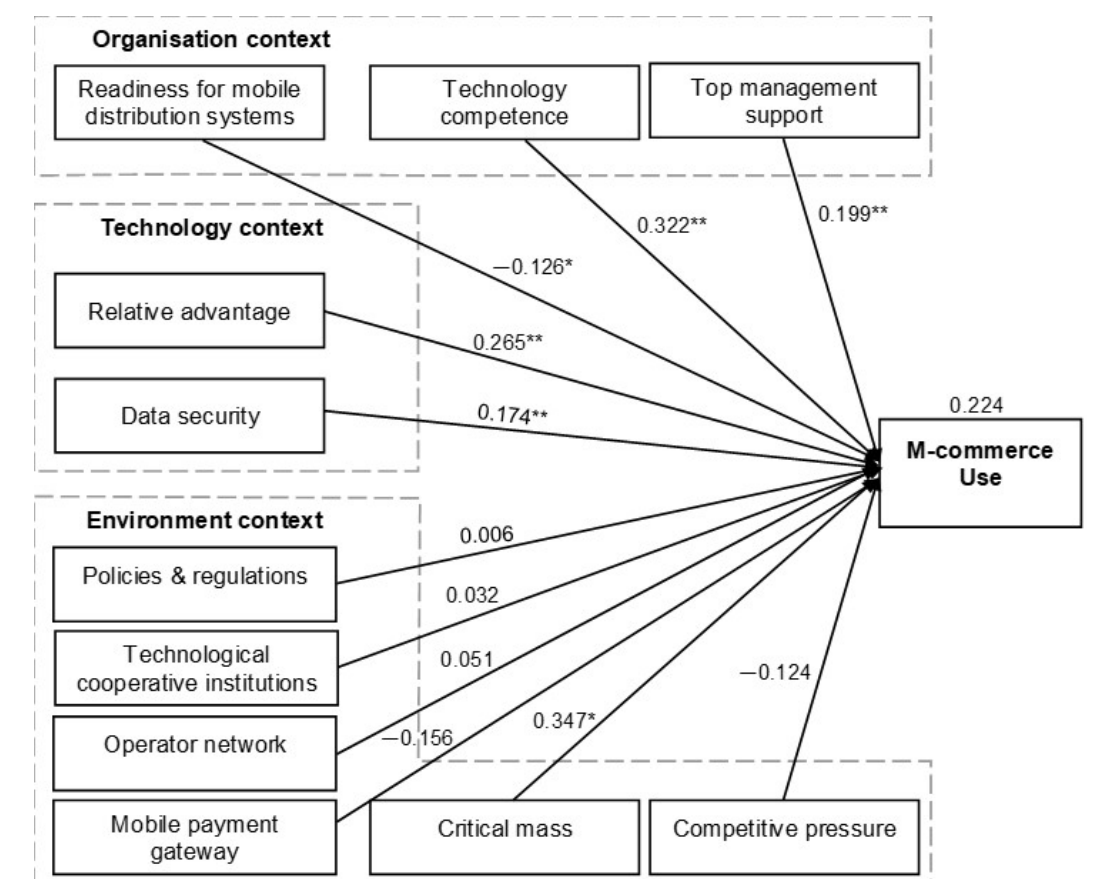
Figure 2. Structural